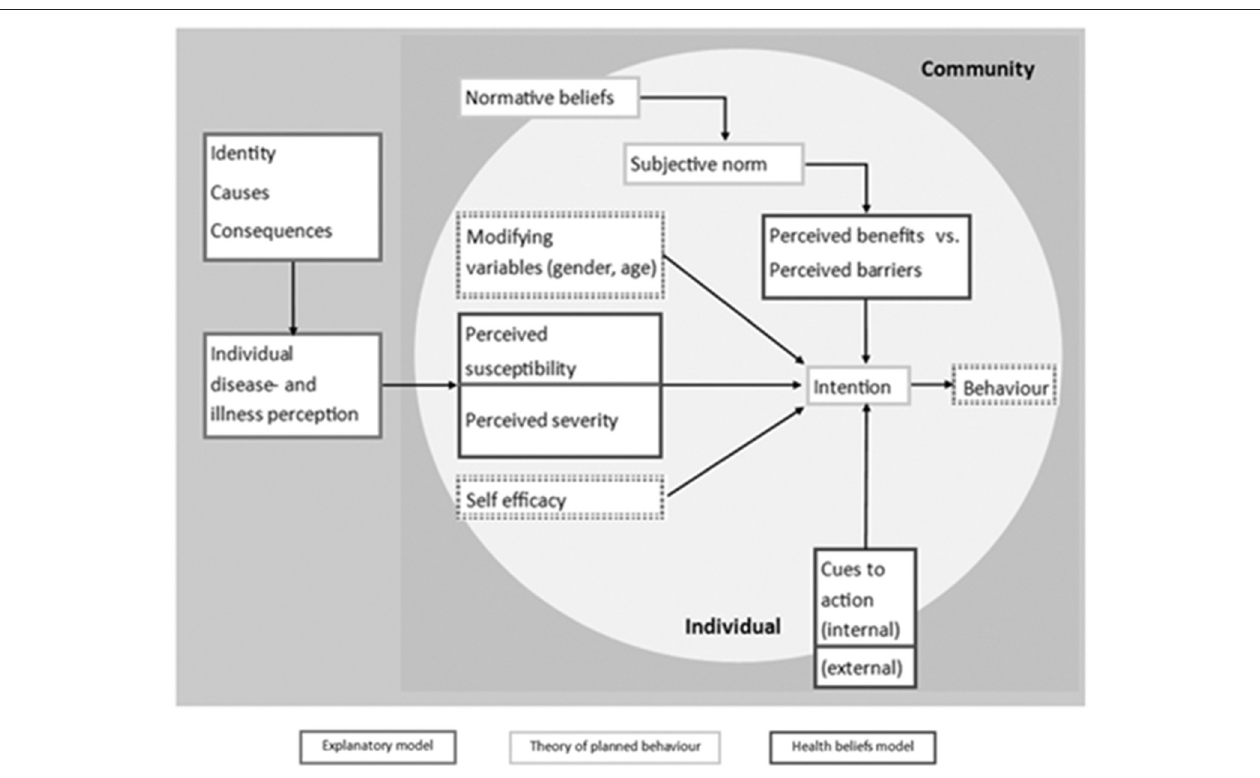
FIGURE 1 | The combined theoretical framework (reprinted with permission), as applied in the SETTINGtool